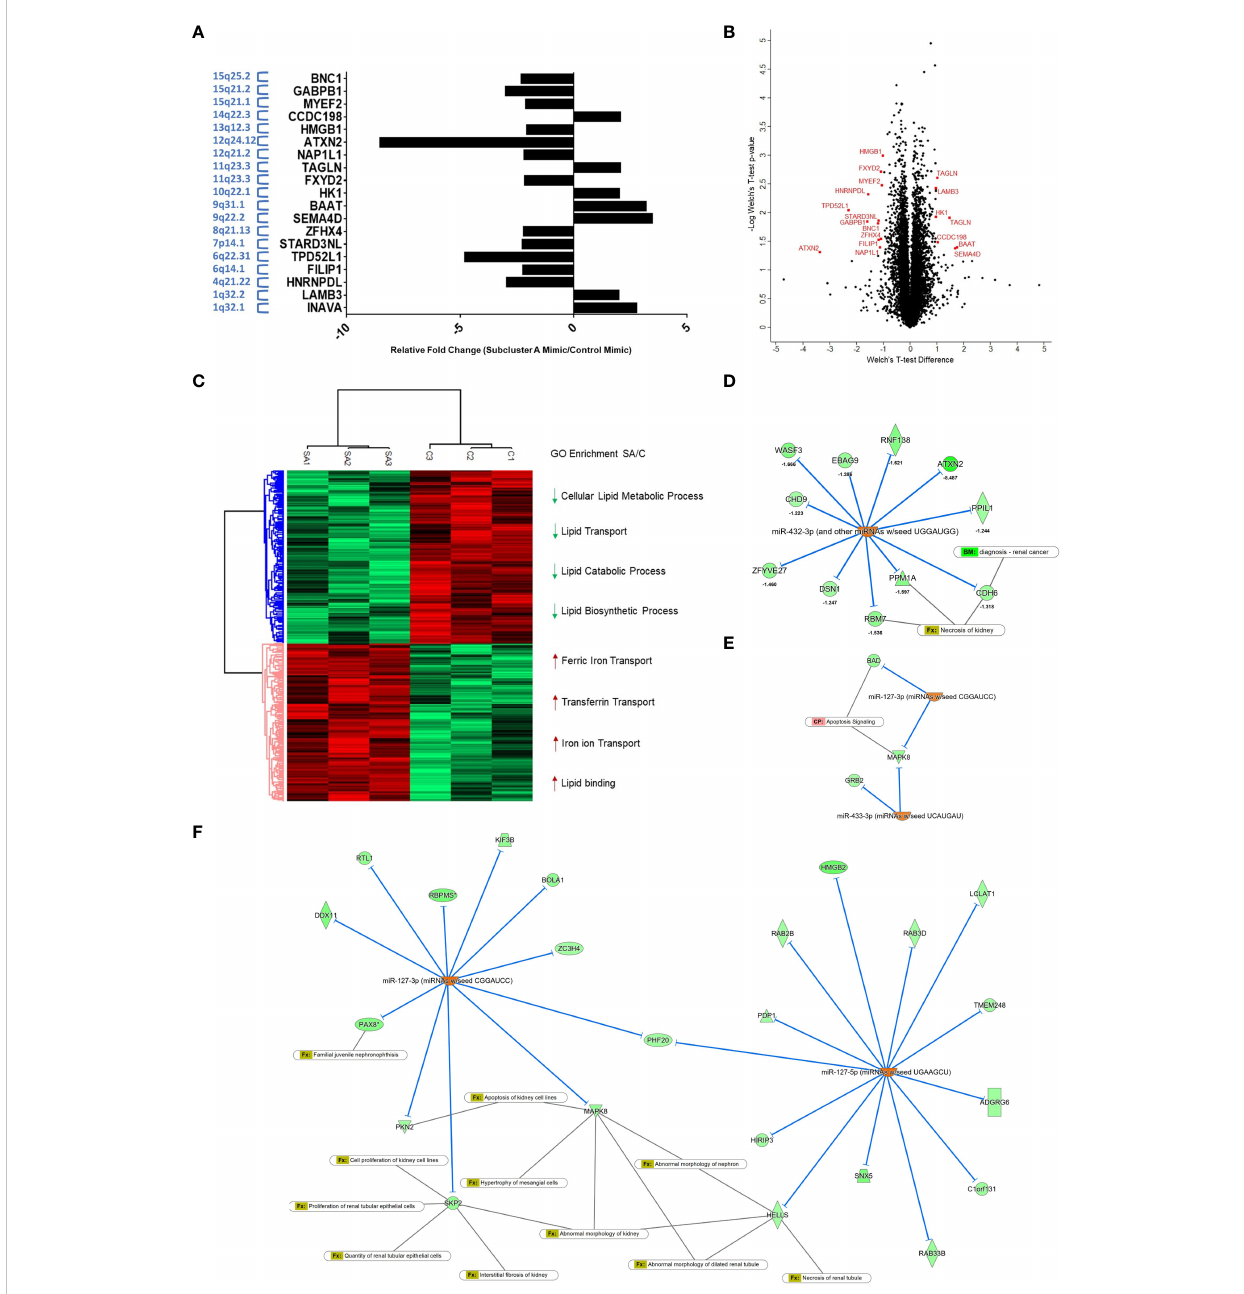
FIGURE 9 Global proteomic pro fi ling of subcluster A miRNA expression in 769-P cells identi fi es ATXN-2 as a downregulated target. (A) Bar graph representation of 19 targets for miRNA subcluster overexpressed cells with p<0.05 and Z-score >1. The chromosomal locations are indicated with the y-axis labels. (B) Volcano plot demonstrating subcluster A miRNA-induced differentially expressed proteins with proteins highlighted in red representing additional fi ltering related to fold-change (Welch ’ s t-test, p<0.05 and Z-score>3). (C) Hierarchical clustering showing two major groups and related cluster-speci fi c gene ontology enrichment results for selected biologically relevant pathways (Fisher ’ s Exact test with a Benjamini- Hochberg FDR<0.05). (D) Analyses via Ingenuity Pathway Analysis was subsequently performed to identify miRNA and proteome dataset relationships. Upregulation of miR-432-3p is predicted to affect the experimentally observed downregulation of several proteins, which included the highly downregulated target ATXN-2, as well as other targets that overlap with renal cancer biomarkers (CDH6) and necrosis of kidney (CDH6 and RBM7). (E) The downstream effect on apoptosis signaling was also a predicted result of decreased expression of BAD and MAPK8, which are targets of miR-127-3p and miR-433-3p. (F) Upregulated miR-127-3p and miR-127-5p are predicted to downregulate several experimentally observed proteins identi fi ed from proteomic analysis, which are associated with pathophysiological processes of the